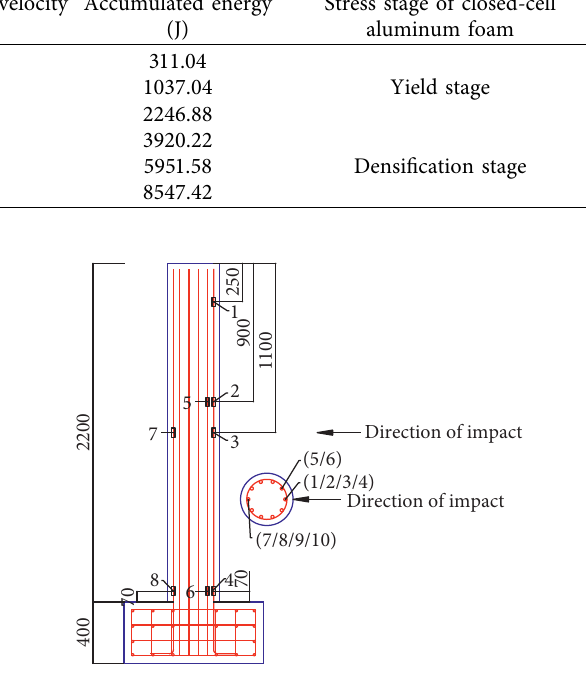
Figure 8: Strain measurement points of the steel bars (unit: mm).